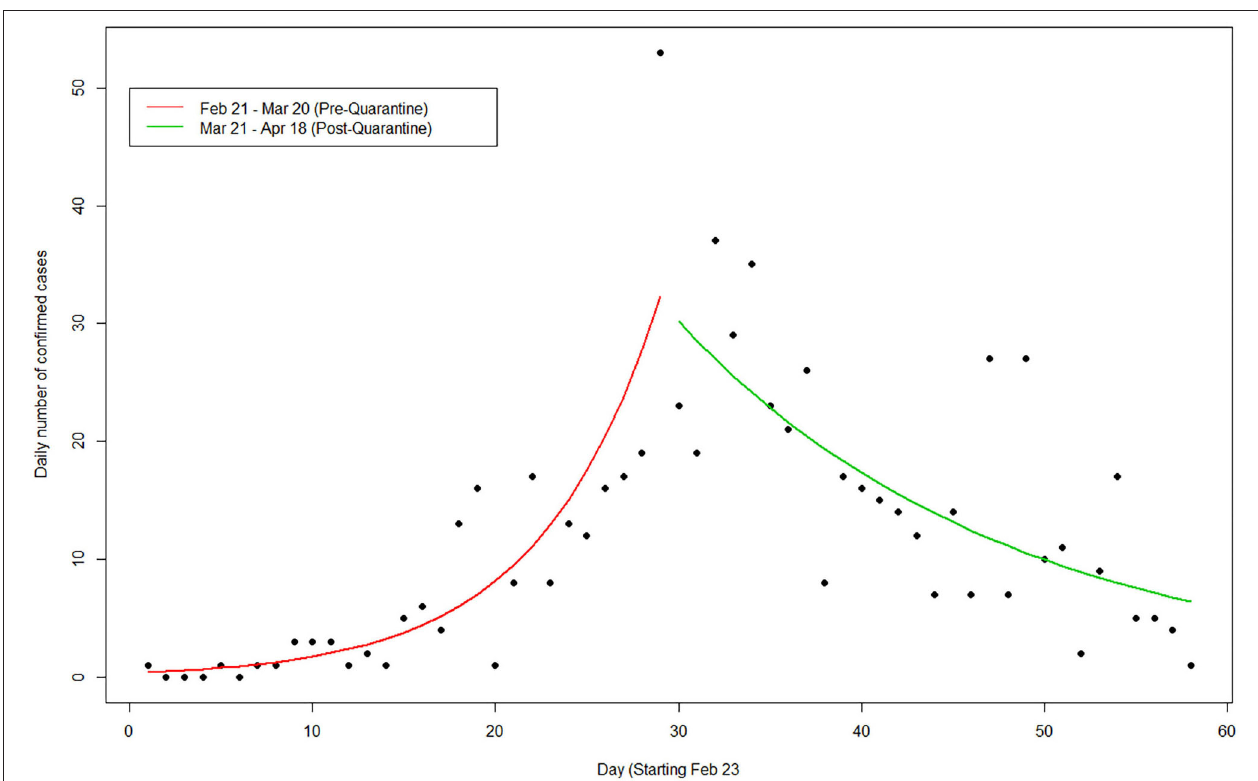
FIGURE 1 | Lebanon confirmed cases rate based on a Poisson regression